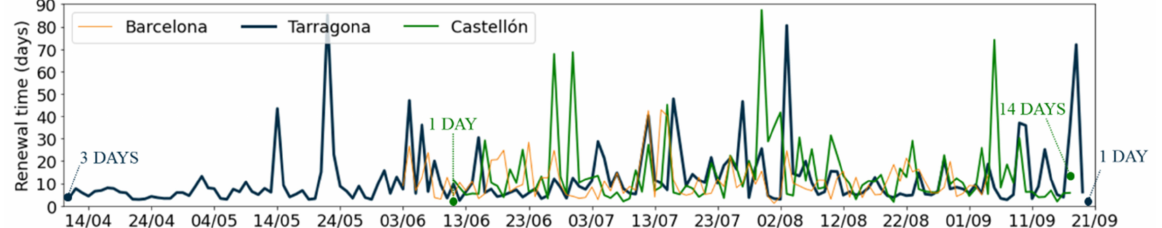
Figure 11. Sample time series of renewal times (in days) for Barcelona (orange line), Tarragona (blue line), and Castell ó n (green line) harbours, estimated by box models and from the recorded velocity